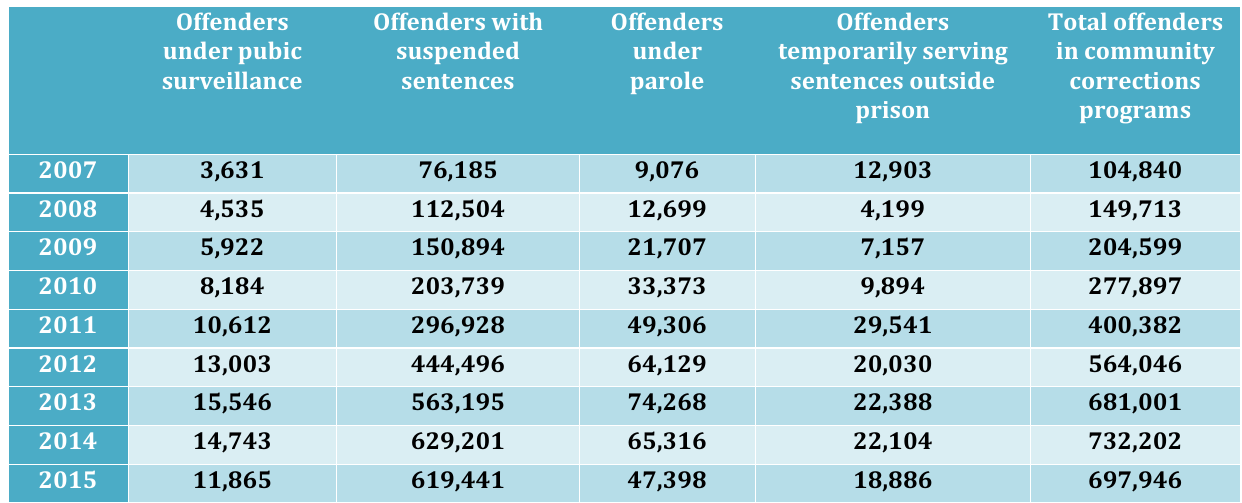
Table 2: Number of offenders in community corrections programs, 2007 – 2015